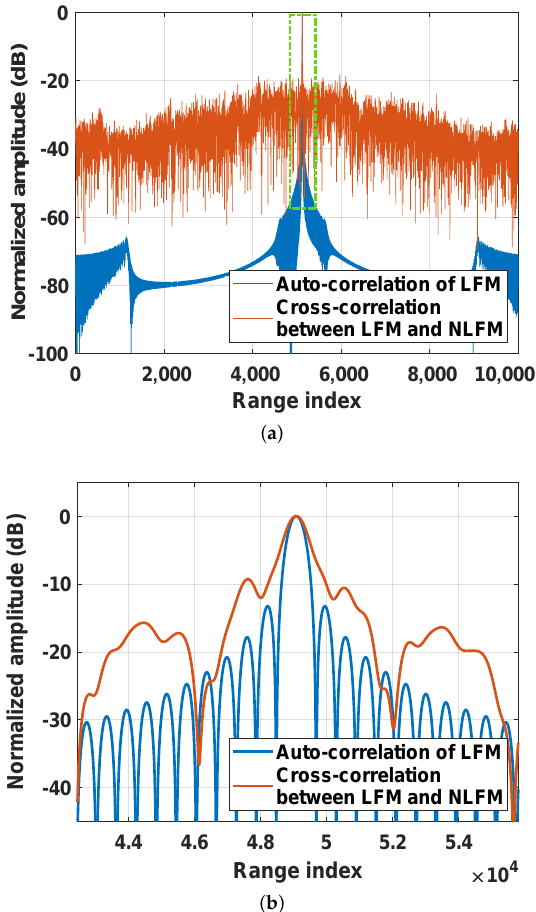
Figure 3. Comparison between LFM waveform and the designed NLFM waveform. ( a ) Autocorrela- tion and cross − correlation functions; ( b ) enlarging and upsampling result of the area marked by the rectangle in ( a